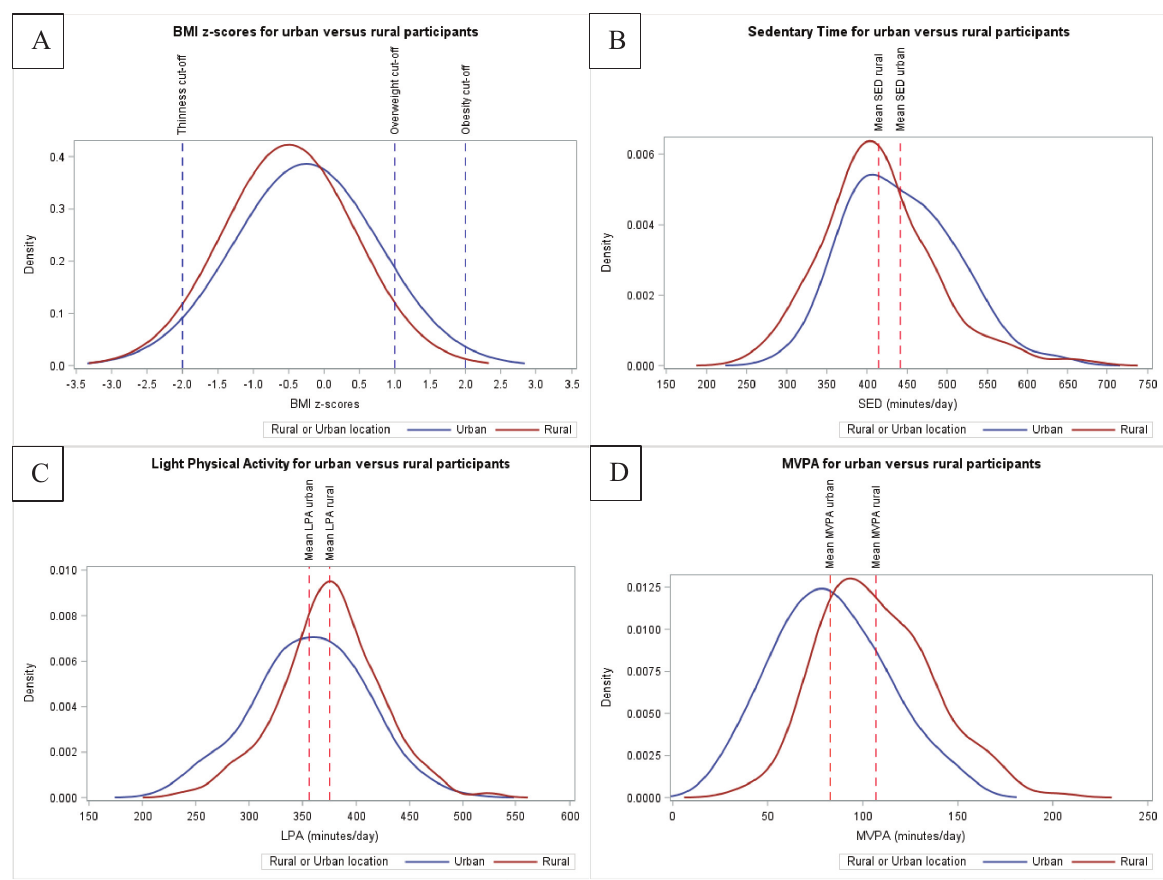
Fig 1. Density curves based on complete cases. Density curves based on complete cases, comparing body mass index z-scores (A), total sedentary time (B), light physical activity (C), and moderate-vigorous-physical activity (D), between urban and rural participants. BMI = Body Mass Index; SED = Total Sedentary Time; LPA = Light Physical Activity; MVPA = Moderate- to Vigorous- Intensity Physical Activity.